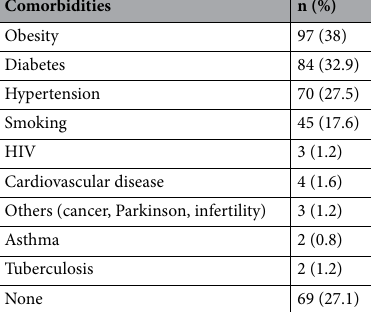
Table 2. Comorbidities.